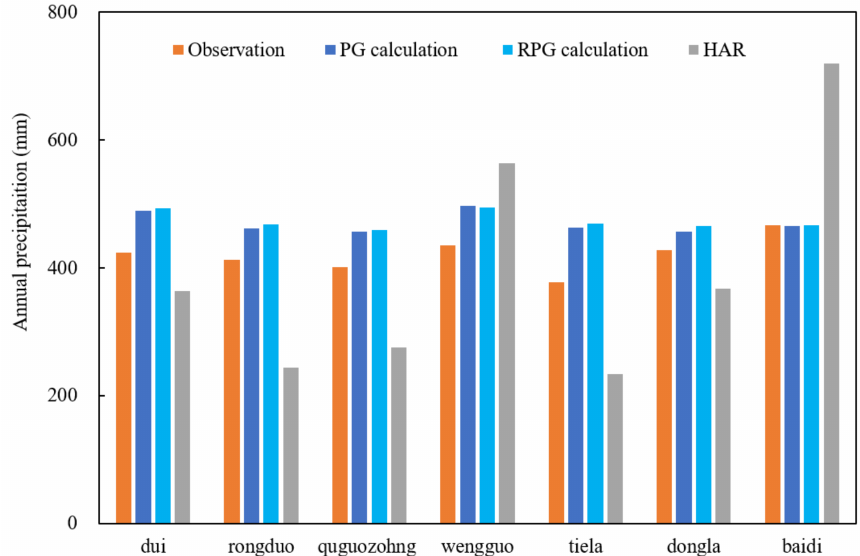
Figure 6. Comparison of the calculated precipitation, observed precipitation, and High Asia Refined (HAR) precipitation in the Yamzho Yumco Lake basin, Tibetan Plateau.